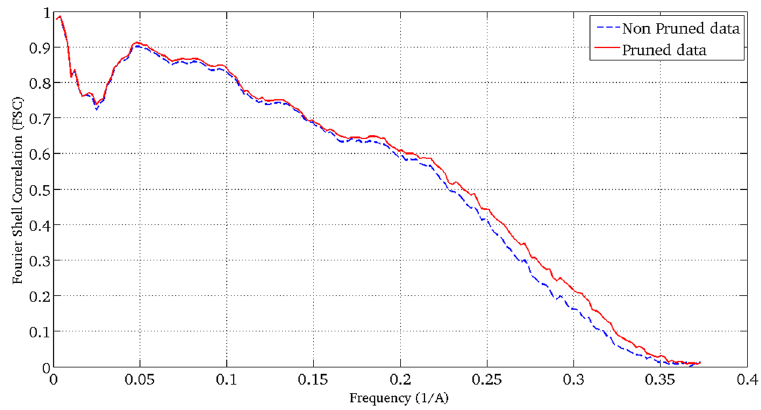
Figure 12. FSC curves when the pruned (red dashed curve) and non-pruned (blue solid curve) 3DEM structures were confronted with the PDB.